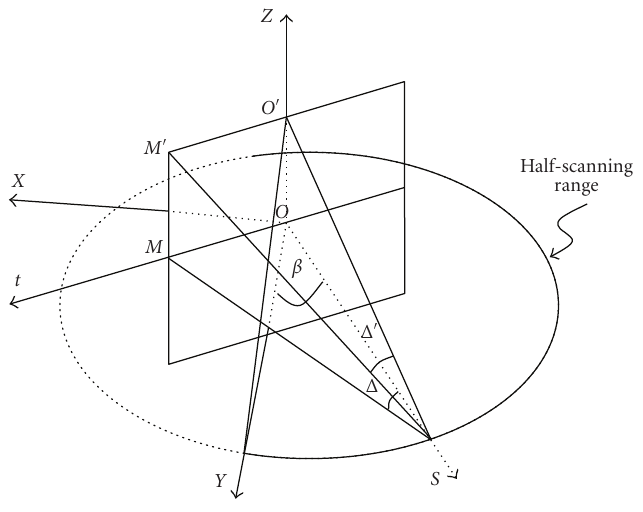
Figure 1: Equal space cone beam geometry with circular